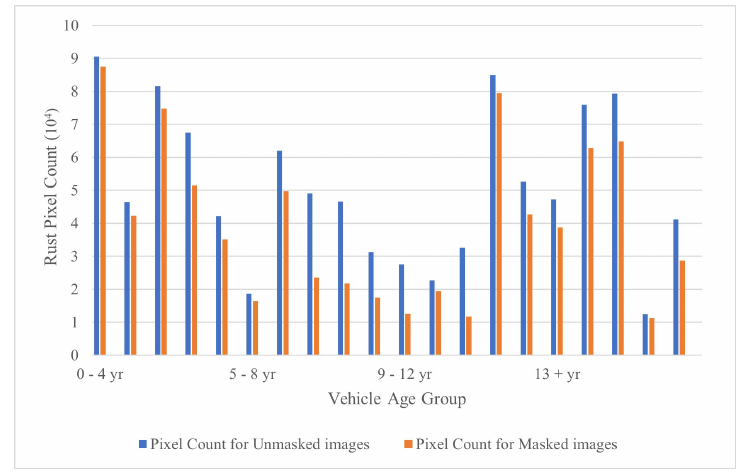
Figure 10. Rust pixel count variations for different vehicle age groups.